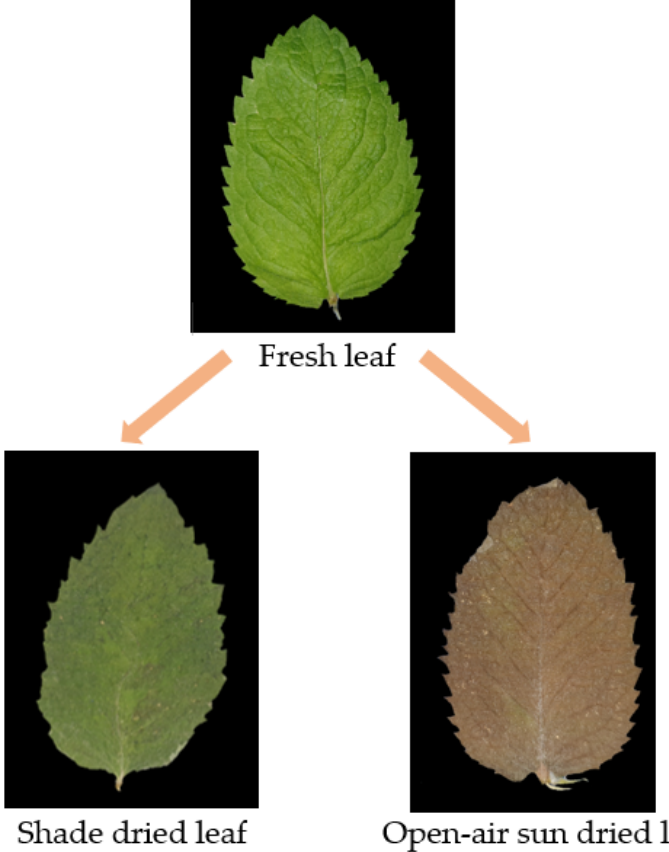
Figure 1. The images of the ventral side (upper surface) of fresh and dried mint leaves. The obtained images were uploaded to a computer with programs for image process- ing and classification using a USB cable. After changing the image background to black and converting the images to the BMP file format, the image processing was carried out using the MaZda software (Ł ó d´z University of Technology, Institute of Electronics, Ł ó d´z, Poland) [18–20]. First, the mint leaf images were converted to individual color channels R , G , B , L , a , b , X , Y , and Z . The exemplary images of the ventral side (upper surface) of fresh and dried mint leaves (Figure 3) and the dorsal side (lower surface) of fresh and dried mint leaves (Figure 4) reveal the differentiation of images depending on the color channel and visible changes in leaves caused by drying. The image segmentation was performed to separate the leaves from the black background based on the pixel brightness intensity, and ROIs (regions of interest) were determined. Each ROI contained one whole mint leaf. For each ROI in each of the nine color channels, 181 texture parameters based on the